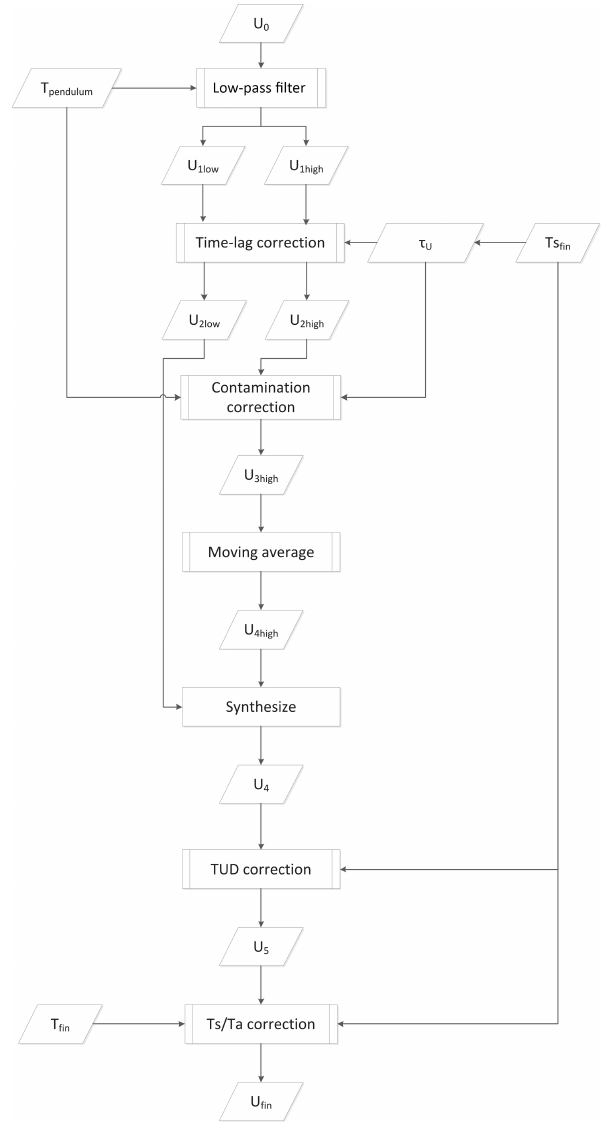
Figure 3. GRUAN data processing flow for RS-11G RH measure- ment (Kizu et al., 2018). U 0 is the uncorrected RH, T pendulum is the period of pendulum motion, U 1low and U 1high are low- and high- frequency components of U 0 , τ U is the sensor response time, T s is the corrected RH sensor temperature, T fin is the corrected final temperature, and U fin is the corrected final RH value. The different shaped boxes indicate as per Fig. 2.